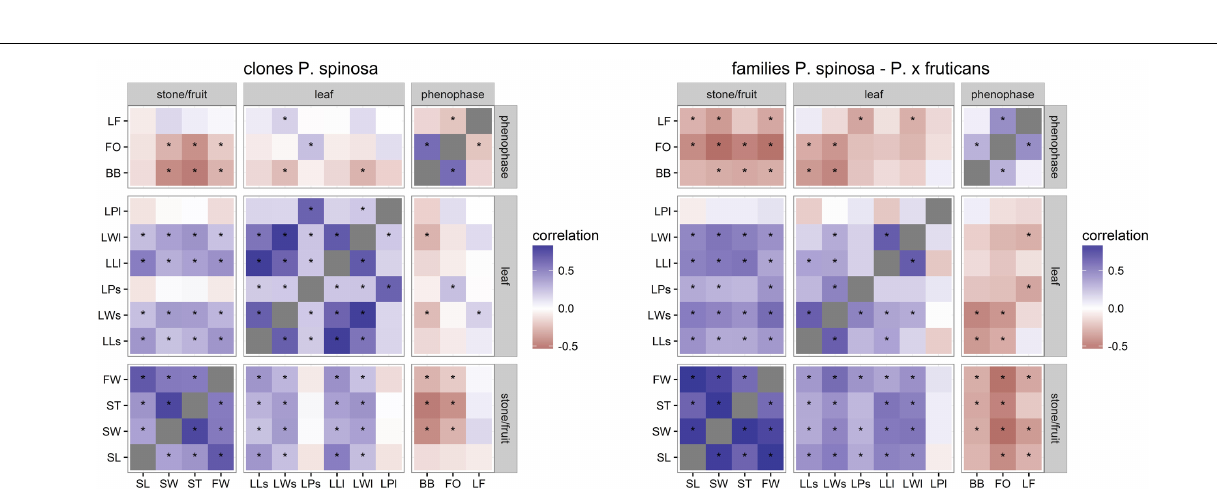
FIGURE 6 | Partitioning of variance for the individual phenophases in the clone and family plantations.